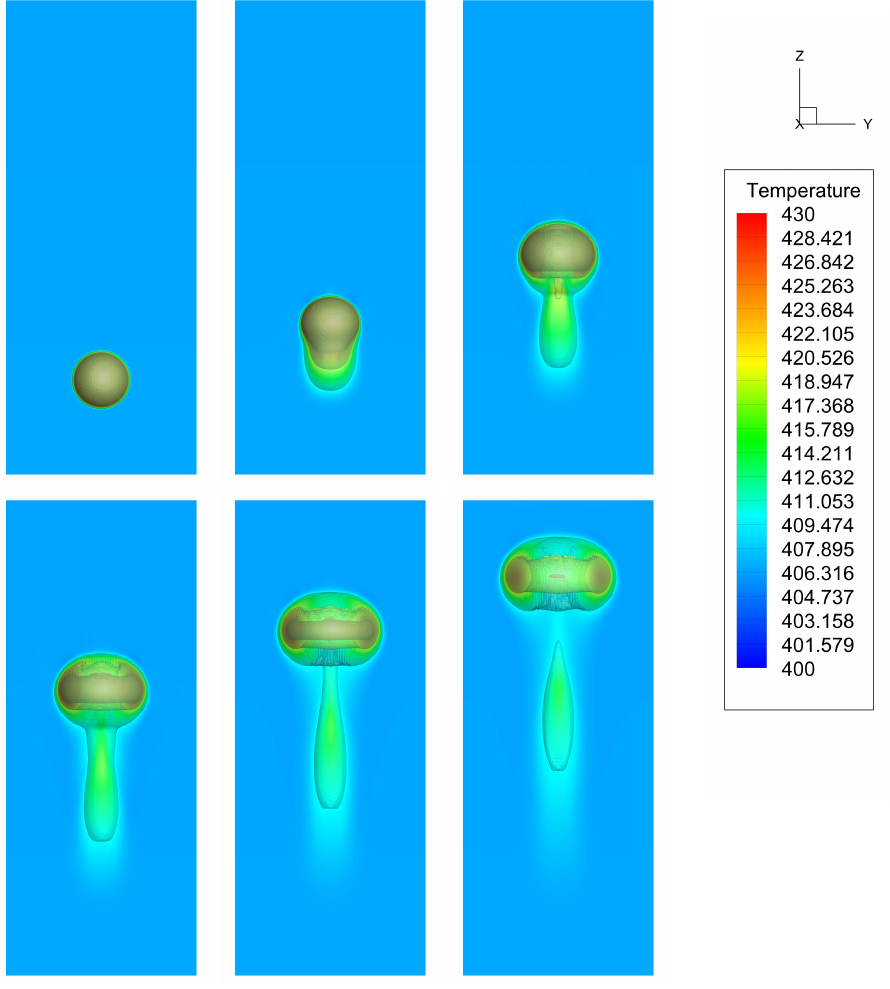
410,420,430 for the 3D rising bubble. From top left ∈ { }